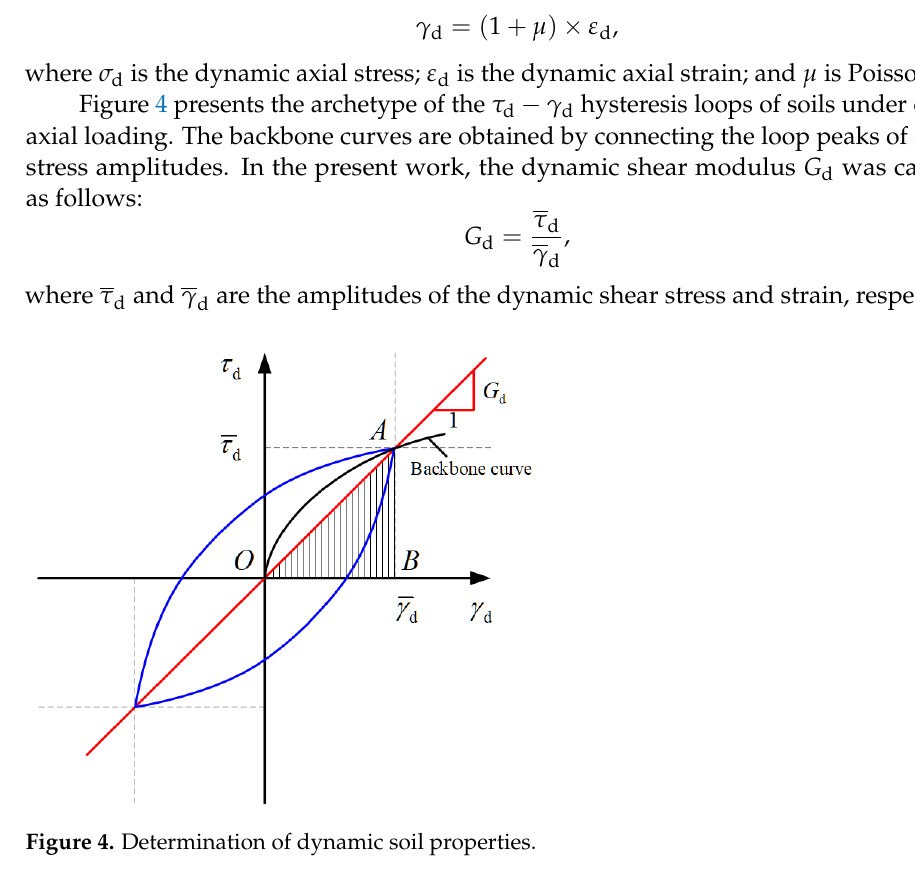
5 of 17 Figure 3. Application diagram of multi-stage cyclic loading.